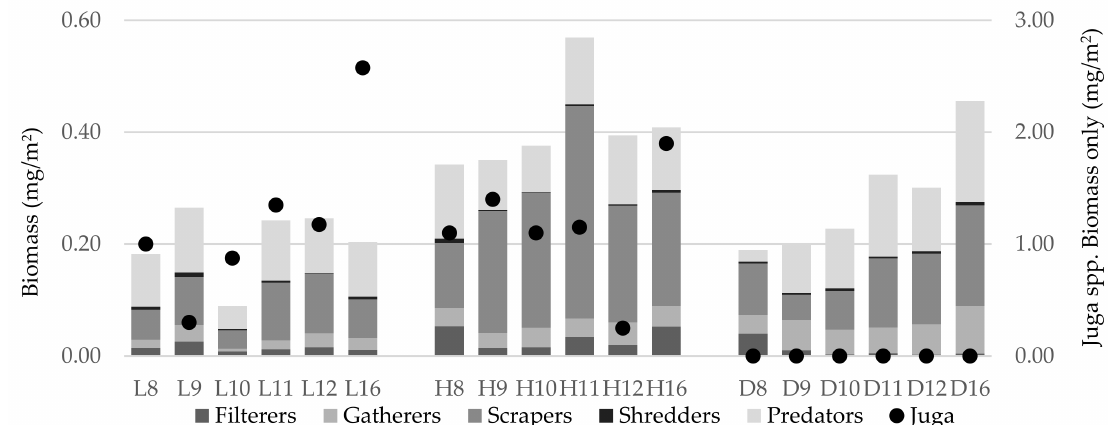
Figure 7. Total biomass (wo/ Juga spp.) (mg/m 2 ) for each disturbance category with functional feeding groups contributions in stacked bar following the 2007 storm in 2008–2012 and again in 2016 on first y-axis. On second y-axis biomass of Juga spp. is shown as a